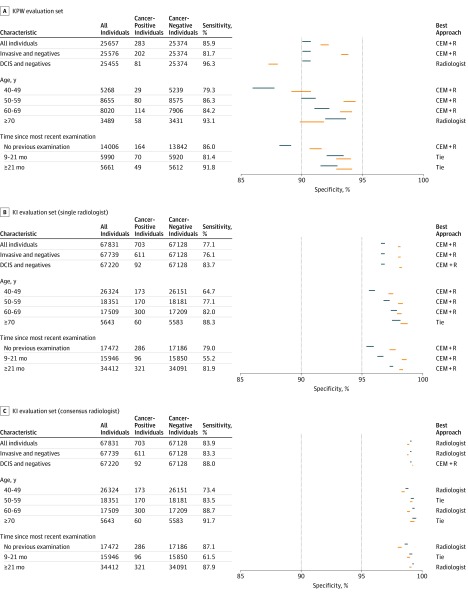
Comparison of the Specificity of Radiologist(s) and CEM+R on Kaiser Permanente Washington (KPW) and Karolinska (KI) DataComparison of the specificity of radiologist(s) and challenge ensemble method + radiologist (CEM+R) for different clinical/demographic conditions on KPW and KI data. For each condition, we report the CI of the specificity of radiologist (blue) and CEM+R (orange) computed at the sensitivity of radiologists. A best performing approach can be identified when the 2 CIs do not overlap. DCIS indicates ductal carcinoma in situ.